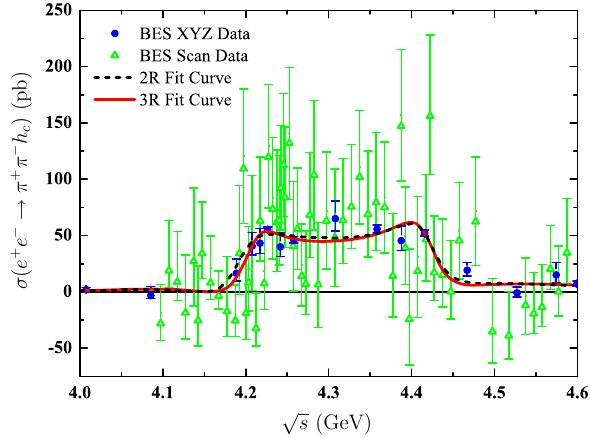
Fig. 3 Our fit to the cross section for the e + e − → π + π − h c reported by the BES III Collaboration [9]. Here, both the XYZ data and scan data are included in the present